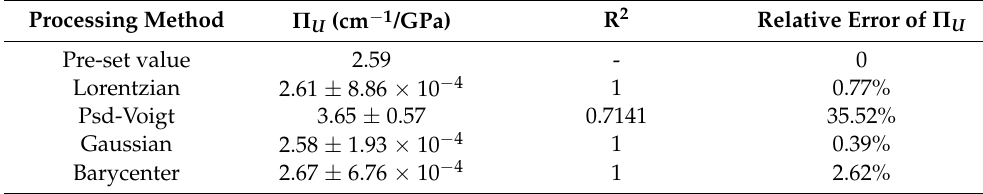
Figure 7. The relationships between luminescence peak shift and uniaxial compressive stress obtained from simulated spectra with different processing methods. ( a ) Lorentzian fitting; ( b ) Psd-Voigt fitting; ( c ) Gaussian fitting; ( d ) Barycenter method. Table 3. Piezospectroscopic coefficients Π U obtained from numerical experiments using different data processing